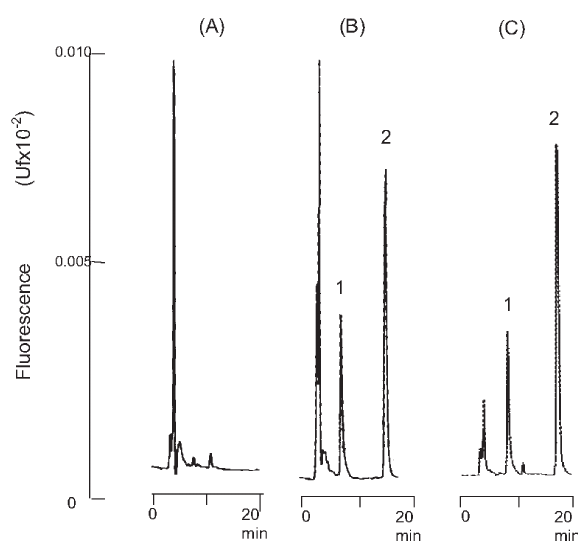
Figure 2 : Chromatographic profile of plasma propranolol and its internal standard (verapamil). Chromatograms: (A) Blank of plasma samples without internal standard (IS) , (B) blank of plasma sample spiked (propranolol 5ng/ mL) plus IS. (C) plasma of a patient receiving propranolol. Retention times: 1) Propranolol 8.4 min and, 2) Verapamil (IS) 17.5 min.